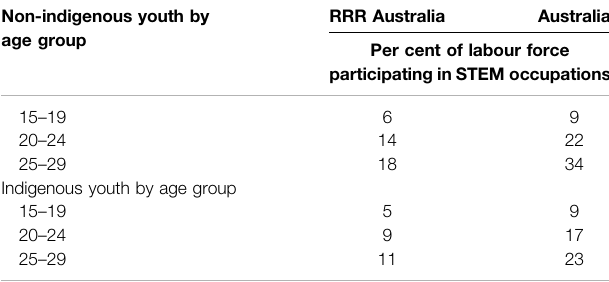
TABLE 1| Per centoflabour force participatingin STEMoccupations, Indigenous and non-Indigenous youth 2 . Non-indigenous youth by age